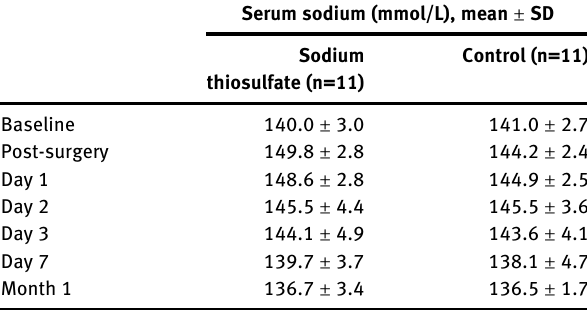
Table  : Sodium results.